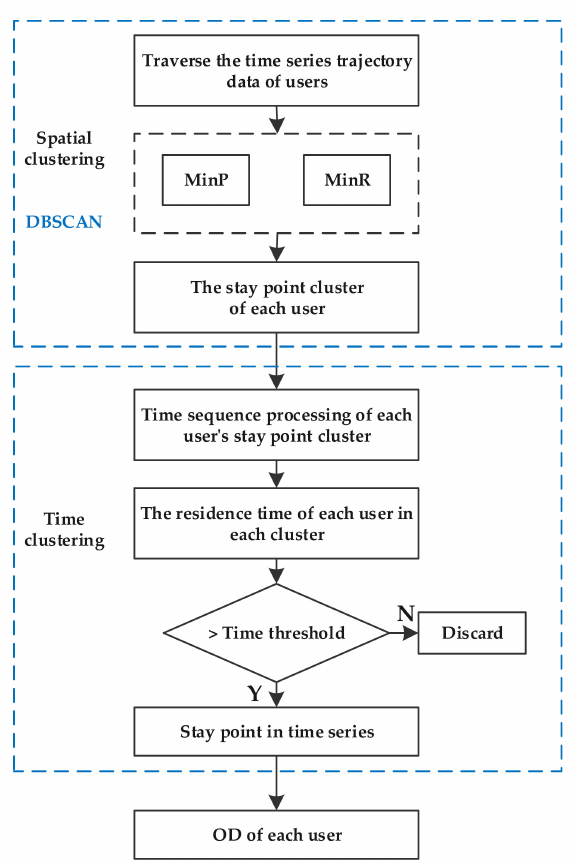
Figure 4. Travel OD extraction algorithm based on spatio-temporal